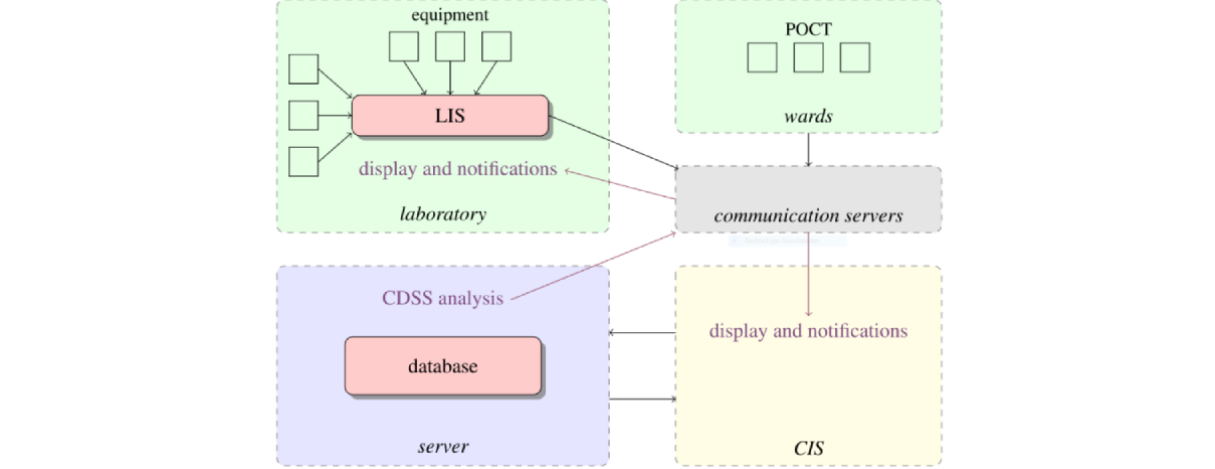
Figure 1. Conceptual computational infrastructure and data flow of a clinical decision support system (CDSS) that performs laboratory diagnostics following a reactive software agent framework. Input components are colored green, knowledge representation and inference components are blue, and output components are yellow. Laboratory parameters are measured by Point-of-Care Testing (POCT) devices and/or at a dedicated laboratory, stored in a Laboratory/Clinic Information System (LIS/CIS), and sent over to one or more information management systems and a server. Nodes indicate components that either generate or process data, while the edges indicate directional data transfer between the components over the